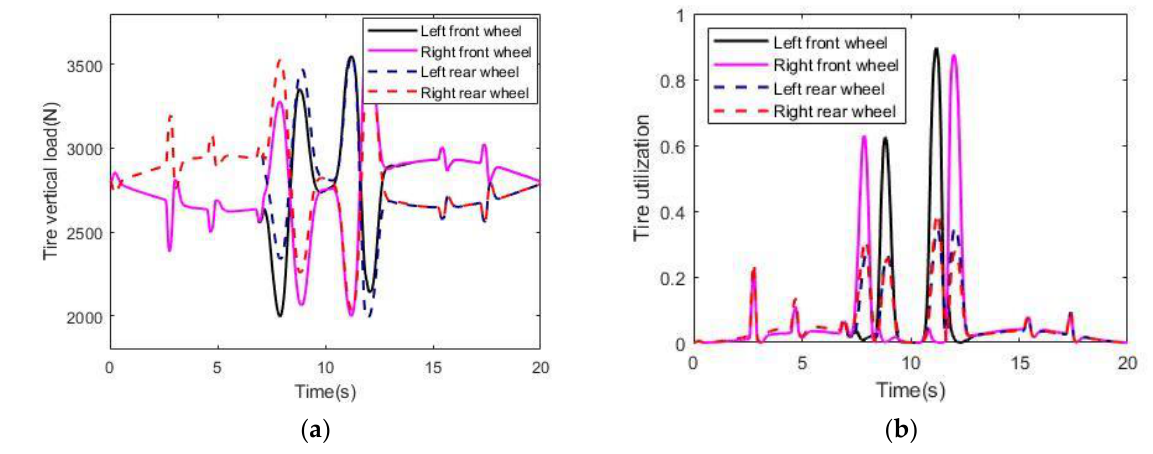
Figure 6. Tire state: ( a ) tire vertical load; ( b )tire utilization.